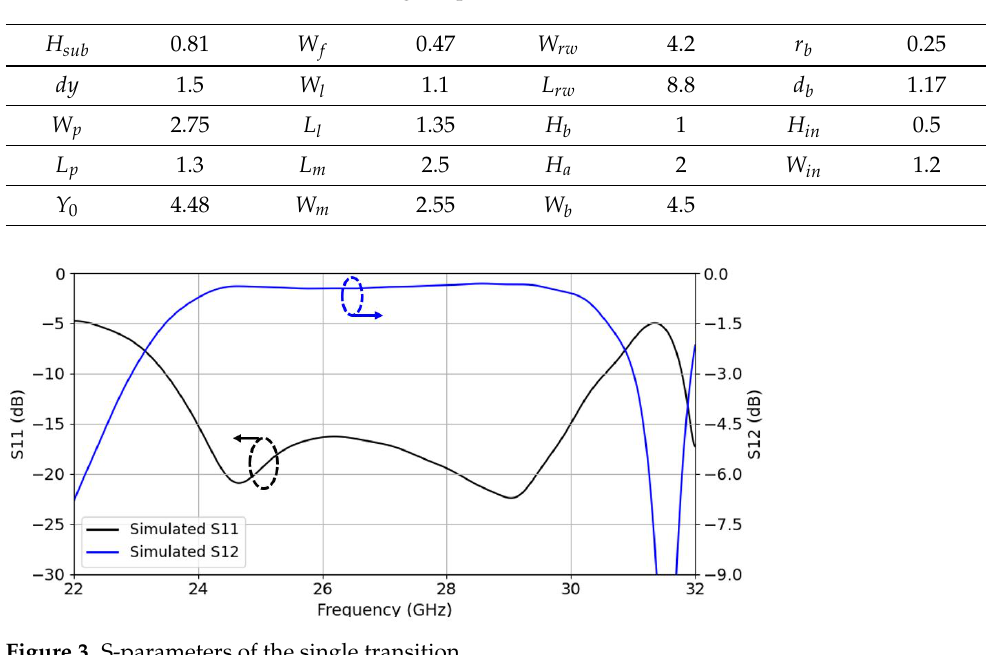
Figure 2. Isometric view of the transition. Table 1. Dimensions in mm of each designed parameter.